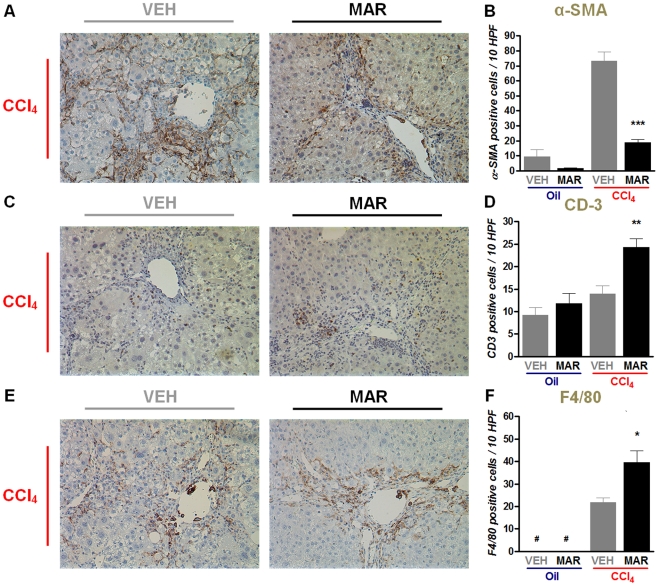
Marimastat decreases hepatic stellate cell (HSC) activation, but increases recruitment of inflammatory cells.Chronic carbon tetrachloride (CCl4) administration in animals treated with Marimastat resulted in a decreased activation of HSCs, as identified by alpha-smooth muscle actin (α-SMA) staining (A). Quantification revealed that following chronic CCl4 administration, Marimastat treated animals had a 74% decrease of activated HSCs, compared to controls (B). Liver sections from animals that were chronically challenged with CCl4 showed that resident T cells (CD3, C,D) and macrophages (F4/80, E,F) counts increased up to 2-fold upon Marimastat treatment. Oil, non-fibrotic control group; CCl4, fibrotic mice; VEH, vehicle treated control group; MAR, Marimastat treated experimental group; α-SMA, alpha-smooth muscle actin; *, P<0.05; **, P<0.01; ***, P<0.001 vs. vehicle alone. Data are expressed as means ± standard error. Original magnification: 200×.